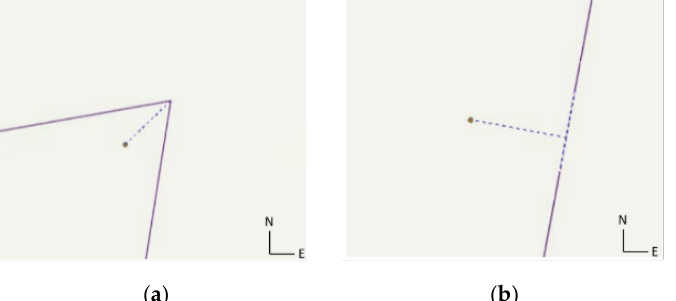
Figure 3. The demonstration of error calculation for an urban cadastral detail survey using the handheld LiDAR points where points mean the survey points measured by a total station and lines were digitized manually from the handheld LiDAR points. ( a ) Planar position error analysis. ( b ) Vertical distance error analysis.